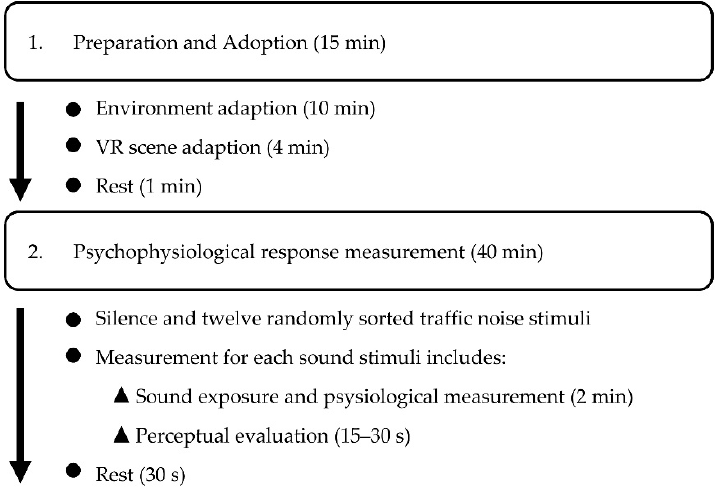
Figure 4. Schematic diagram of the experiment process.